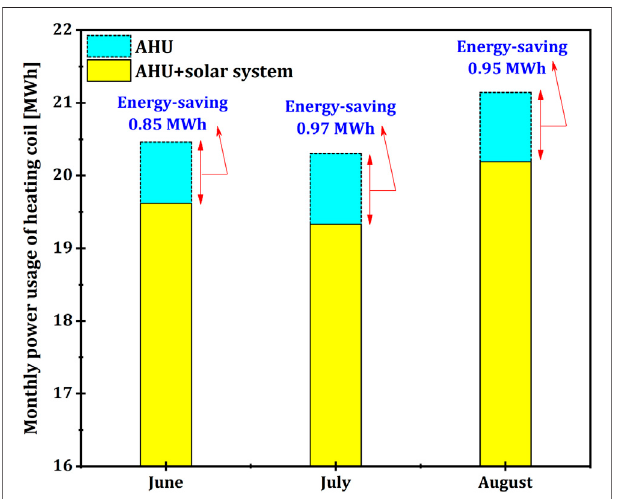
FIGURE 11 | The comparison of PC HC between simple AHU and solar- assisted AHU.